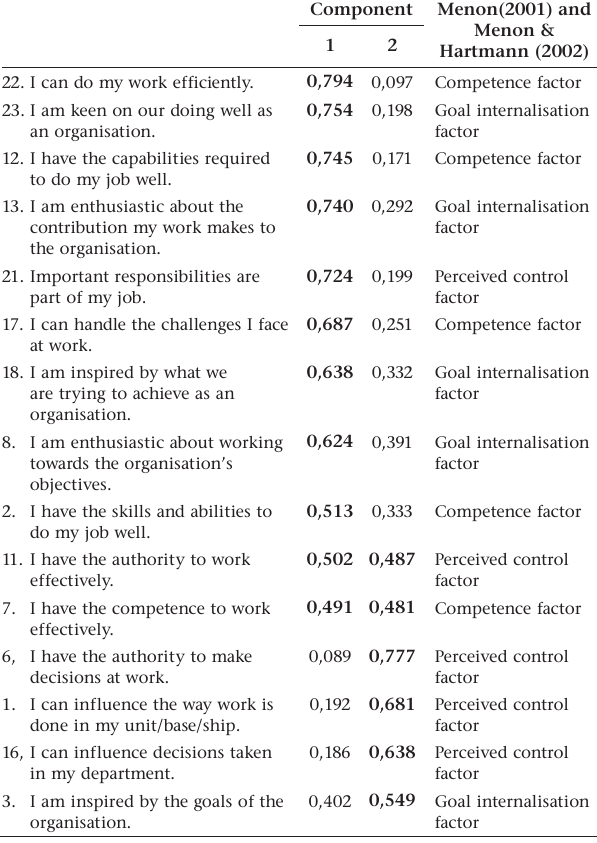
table 1 F actor analysis : unspeciFied number oF Factors and compared